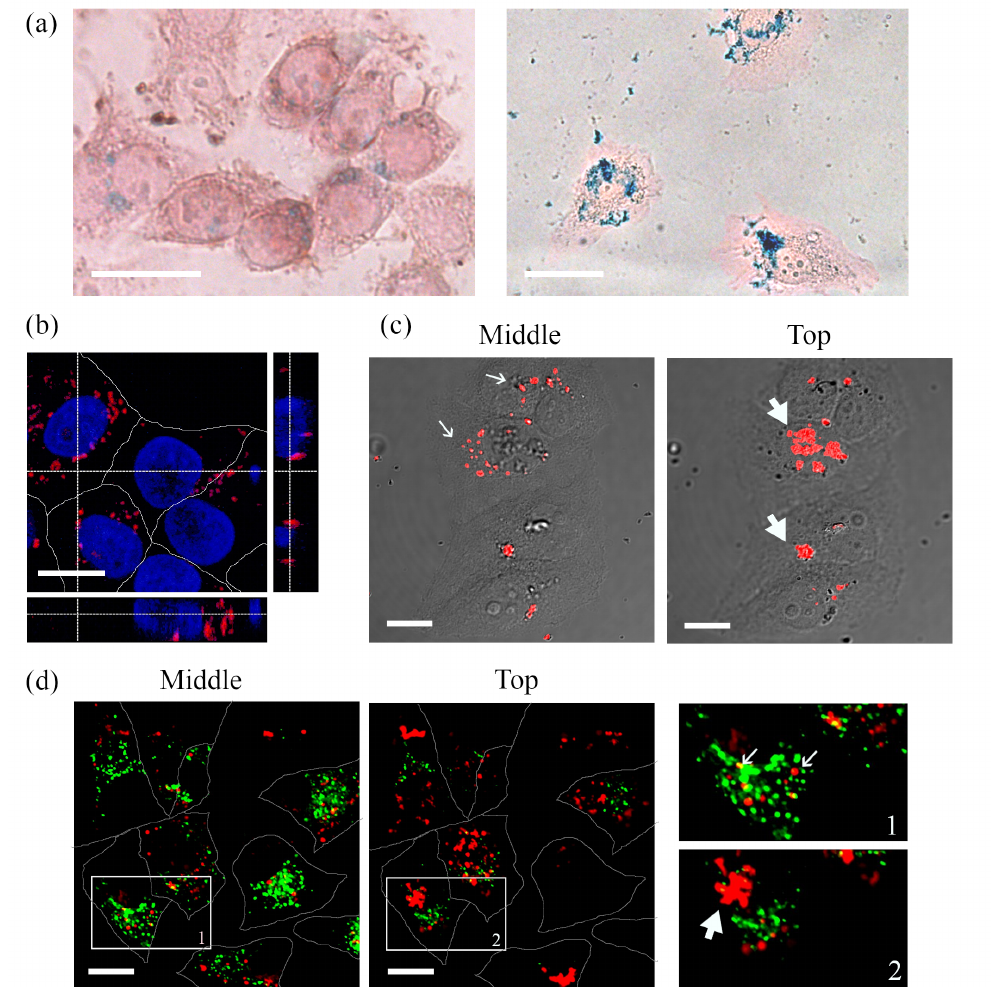
Figure 7. Microscopy of HeLa cells after incubation with QD-SPIONs (1:1 concentration ratio of QDs and SPIONs) for 24 h. ( a ) Light microscopy of cells stained with Perls Prussian blue to detect iron compounds after the incubation of cells with QD-SPION nanocomposites at concentrations of 25 nM (left) and 140 nM ( right ). ( b – d ) Confocal images of cells after incubation with QD-SPIONs (20 nM): ( b ) Optical slice of HeLa cells at the nucleus level (red channel—QD-SPIONs, blue channel—Hoechst 33342); below and on the right, there are orthogonal sections of cells obtained as a result of scanning along the XZ and YZ axes. ( c ) Overlay of DIC images of cells and the QD-SPION luminescence channel. Localization of QD-SPIONs represented by optical sections from the Z-series at the level of the nucleus (middle) and on the apical surface ( top ) of HeLa cells. ( d ) Live cells stained with LysoTracker Green DND-26 for 20 min before confocal imaging. Visualization is represented by optical sections from the Z-series at the level of the nucleus (middle) and on the apical surface ( top ) of the cells. The insets 1 and 2 represent enlarged views (3×) of the corresponding boxed region of the cell. Thin arrows show examples of QD-SPIONs inside cells; thick arrows indicate the accumulation of QD-SPIONs on the cell surface. Photoluminescence of QDs excited at 405 nm and recorded in the range of 520–620 nm. Hoechst 33342 fluorescence was excited at 405 nm and recorded in the range of 430–480 nm. LysoTracker Green fluorescence was excited at 488 nm and recorded in the 500–550 nm range. Scale bars 15 µ